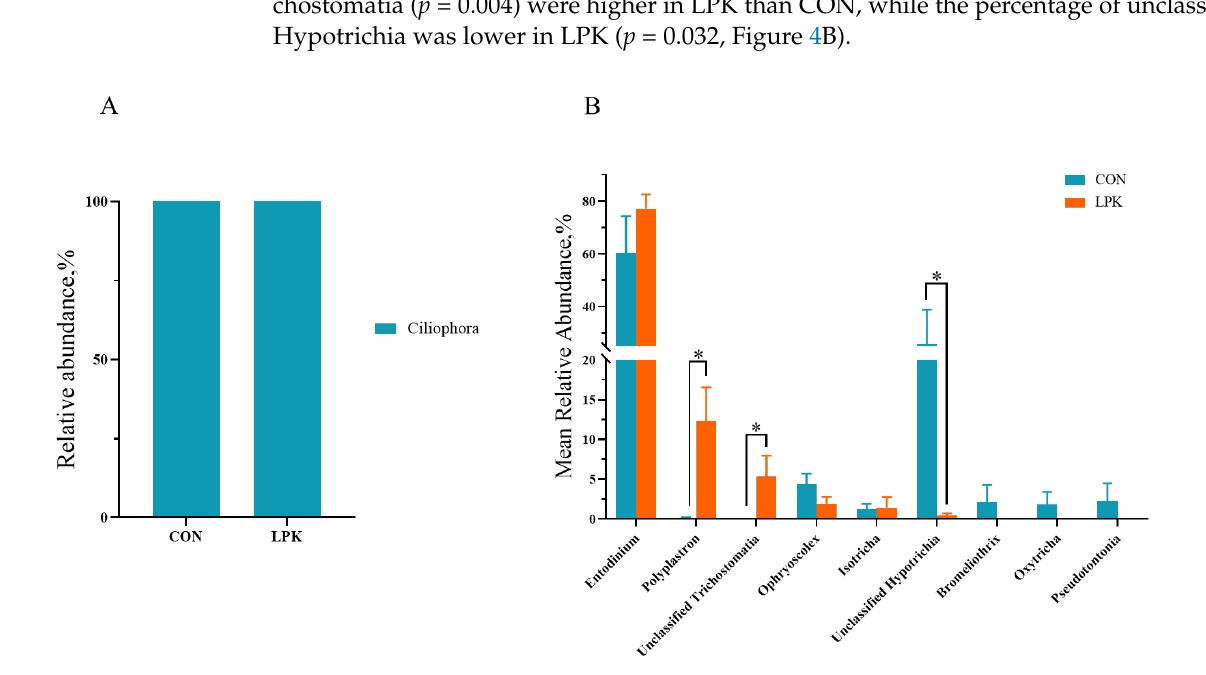
Figure 4. The rumen protozoa community in Hu sheep: ( A ) The mean relative abundance of phylum ≥ 1% in at least one group is present. ( B ) The mean relative abundance of genus ≥ 1% in at least one group is present. Error bars, SEM. * p < 0.05. CON = control group; LPK = live Pichia kudriavzevii group.